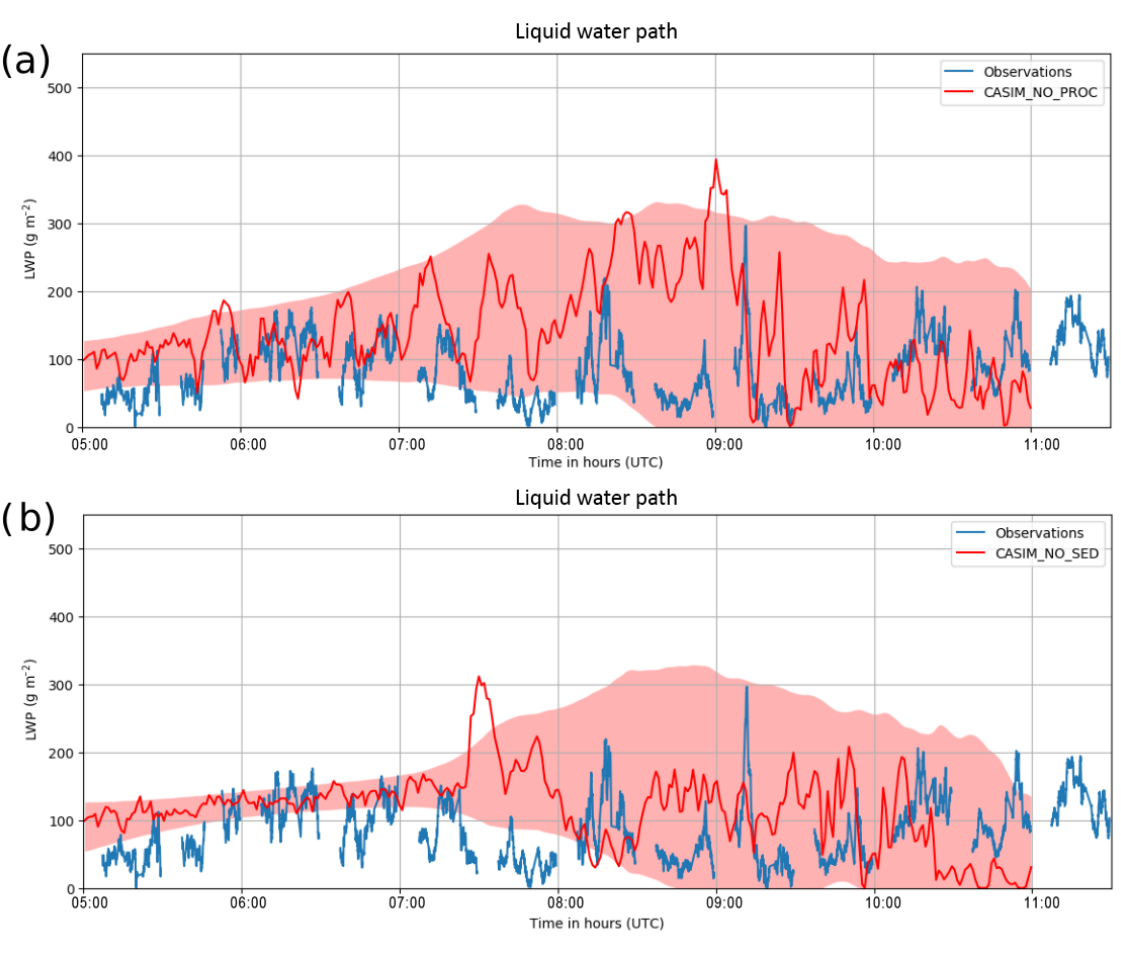
Figure 8. (a) Comparison of LWP time series at Savé from 5 July 2016 (blue) as measured by the microwave radiometer (Wieser et al., 2016), with simulated LWP from CASIM_NO_PROC, showing the evolution of LWP at the centre of the model domain (red line) and the LWP variability within the whole domain (red shading), expressed as ± 2 standard deviations from the domain mean value. Panel (b) as (a) but for